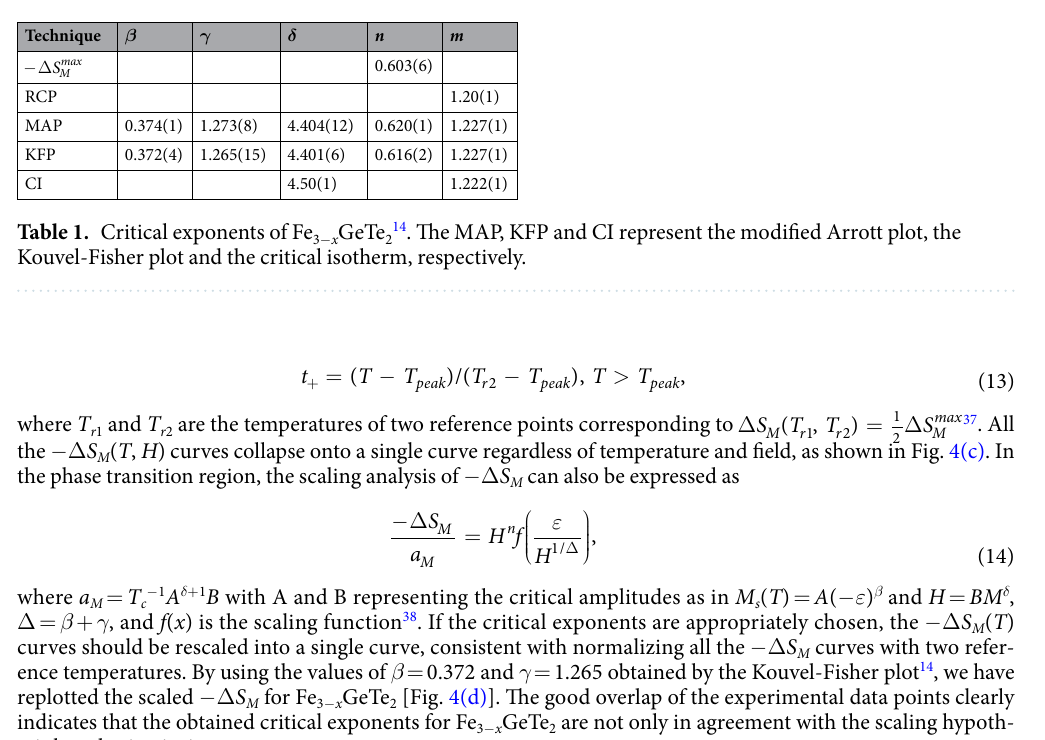
Technique β γ δ